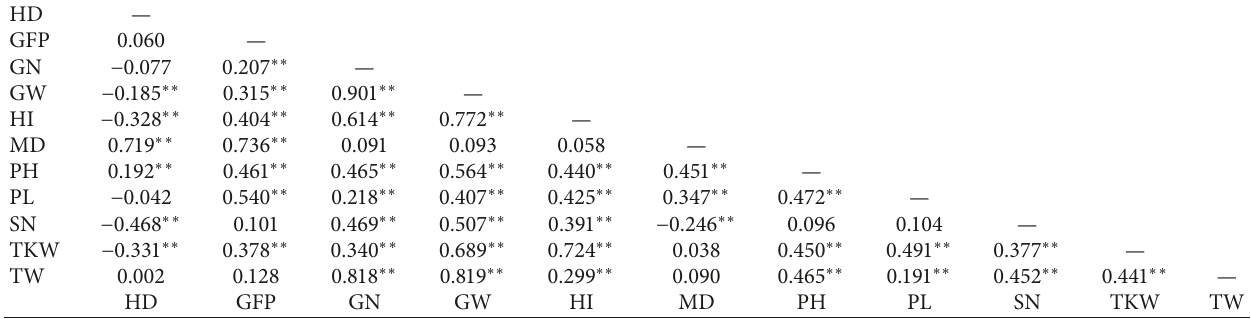
Table 5: Pairwise correlation Pearson coefficients between agronomical traits of 13 barley genotypes using overall means from all tested environments.